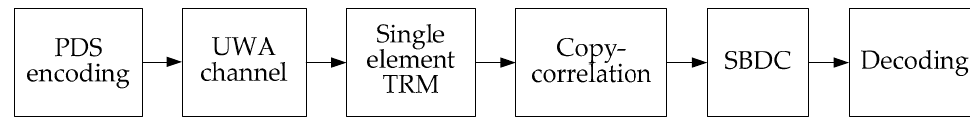
Figure 1. The flow chart of TRM-SBDC UWA communication system.